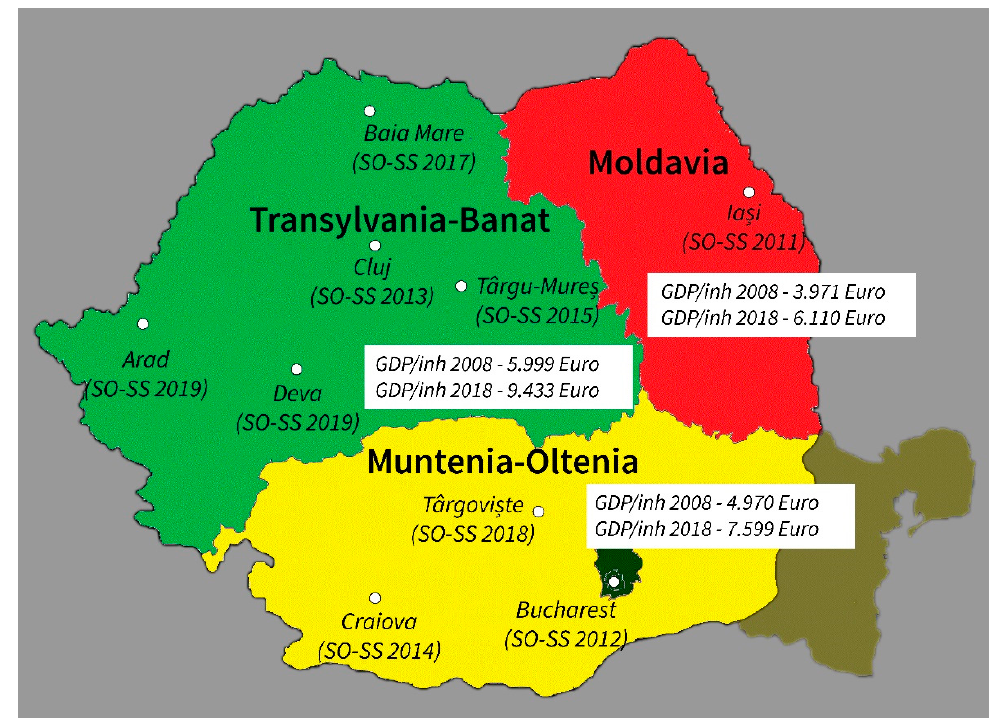
Figure 1. Distribution of cities hosting SO-SS events within the geo-economic regions of the country and reported GDP values for each region in 2008 and 2018 respectively.